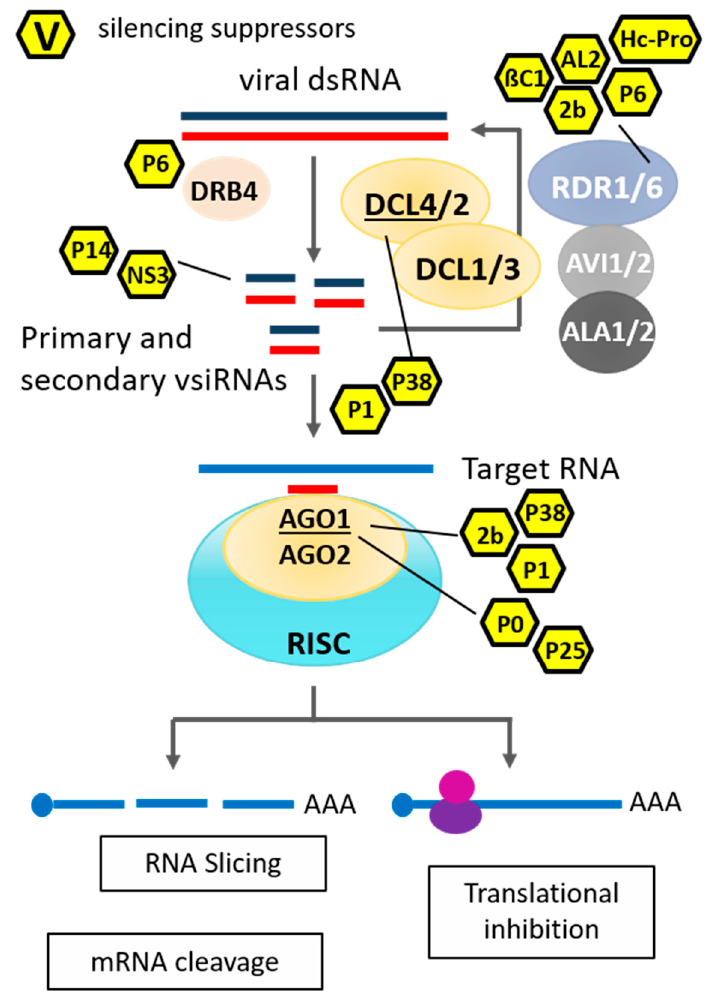
Figure 1. Antiviral RNA silencing starts with the initial processing or cleavage of a precursor viral dsRNA into short 21–24 nucleotide vsiRNA duplexes by RNaseIII-like enzymes called DCLs. Double-stranded siRNAs are incorporated into an RNA-induced silencing complex RISC, and the activated RISC subsequently unwinds the vsiRNA, thereby generating an antisense (or guide) strand that targets complementary mRNA transcripts via base-pairing interactions. Subsequent degradation of the targeted viral mRNA or inhibition of translation can interfere with protein biosynthesis.